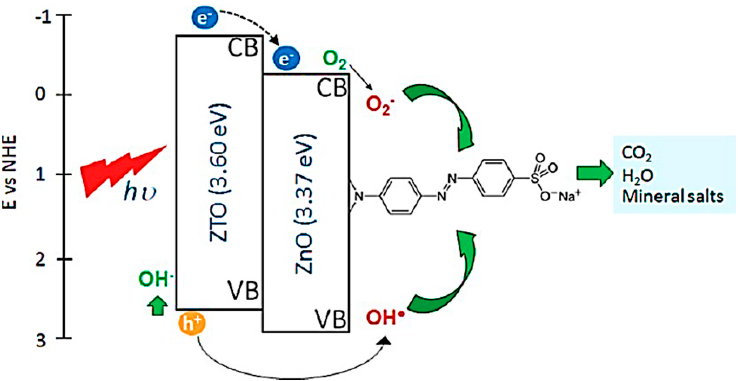
Figure 9. Possible energy band diagram of a ZnO/ZTO nanocomposite showing the photo-excited electron transfer from the higher-energy-level CB of ZTO to the lower CB of ZnO. Reproduced with permission from [205]. Copyright American Chemistry Society,